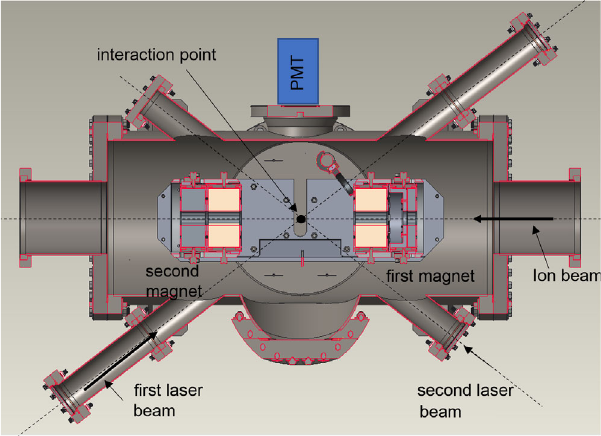
FIG. 1. Layout of the SNS LACE experiment interaction region optimized for single-step excitation